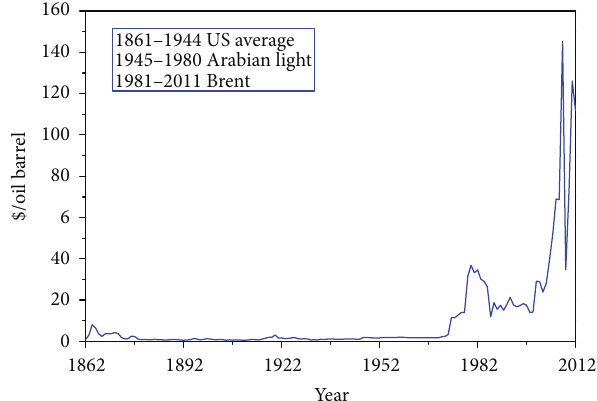
Figure 1: Historical world oil prices in the period